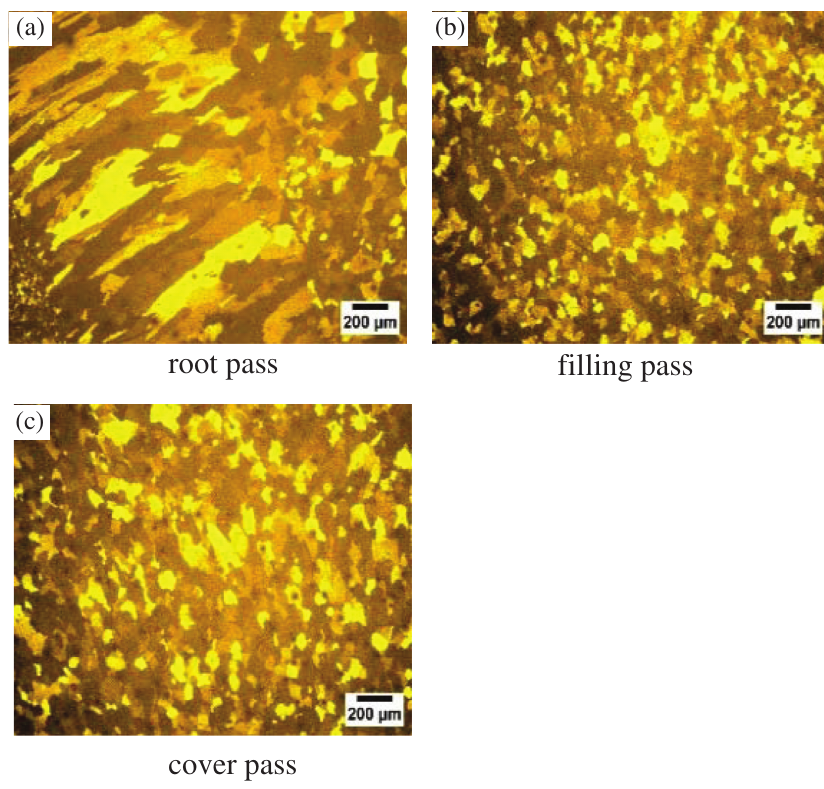
Figure 3: Microstructure of weld by ER5356.